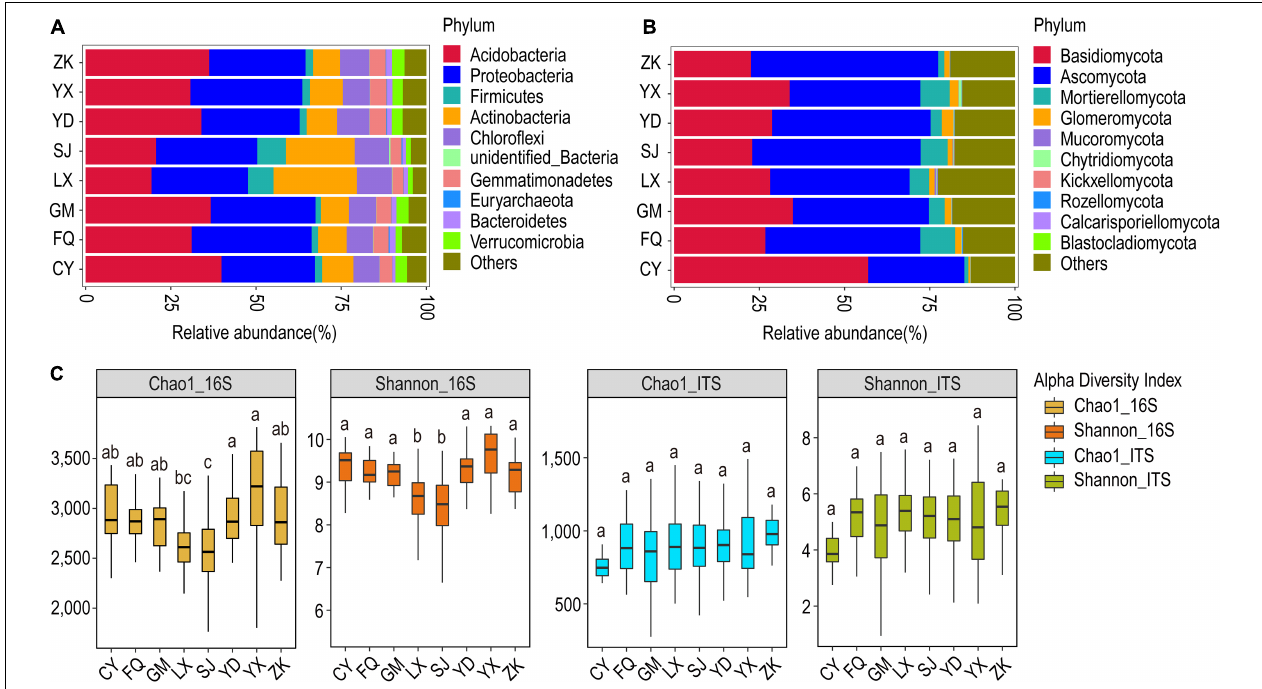
FIGURE 4 | Relative abundance and α -diversity indices of soil bacterial and fungal communities in different region groups. (A) Relative abundance of bacteria at the phylum classification level; (B) relative abundance of fungi at the phylum classification level. (C) Chao1 and Shannon indices of bacteria and fungi. Different lowercase letters indicate significant differences between subgroups ( p < 0 . 05). CY, Cang Yuan; GM, Geng Ma; ZK, Zhen Kang; LX, Lin Xiang; SJ, Shuang Jiang; FQ, Feng Qing; YD, Yong De; YX, Yun